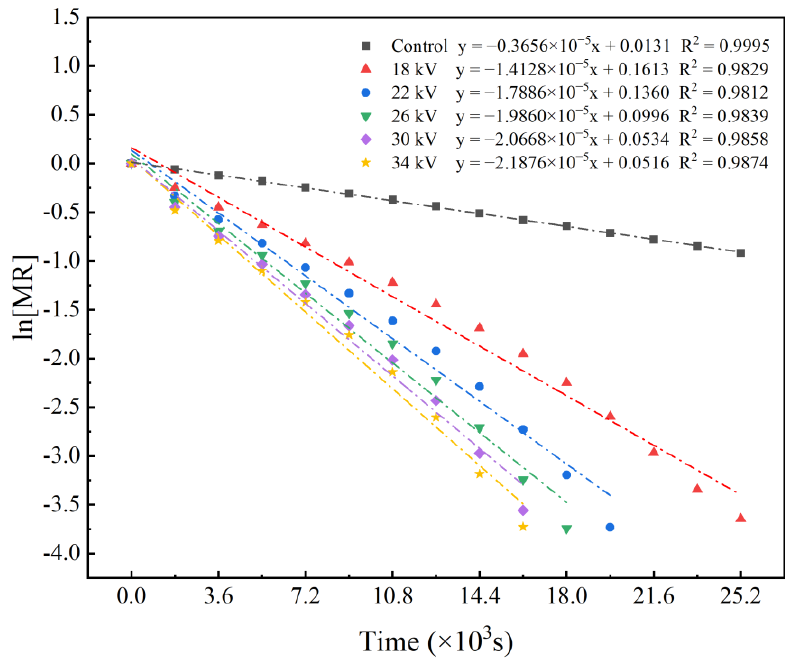
Figure 4. Linear evaluation of ln [MR] over time.